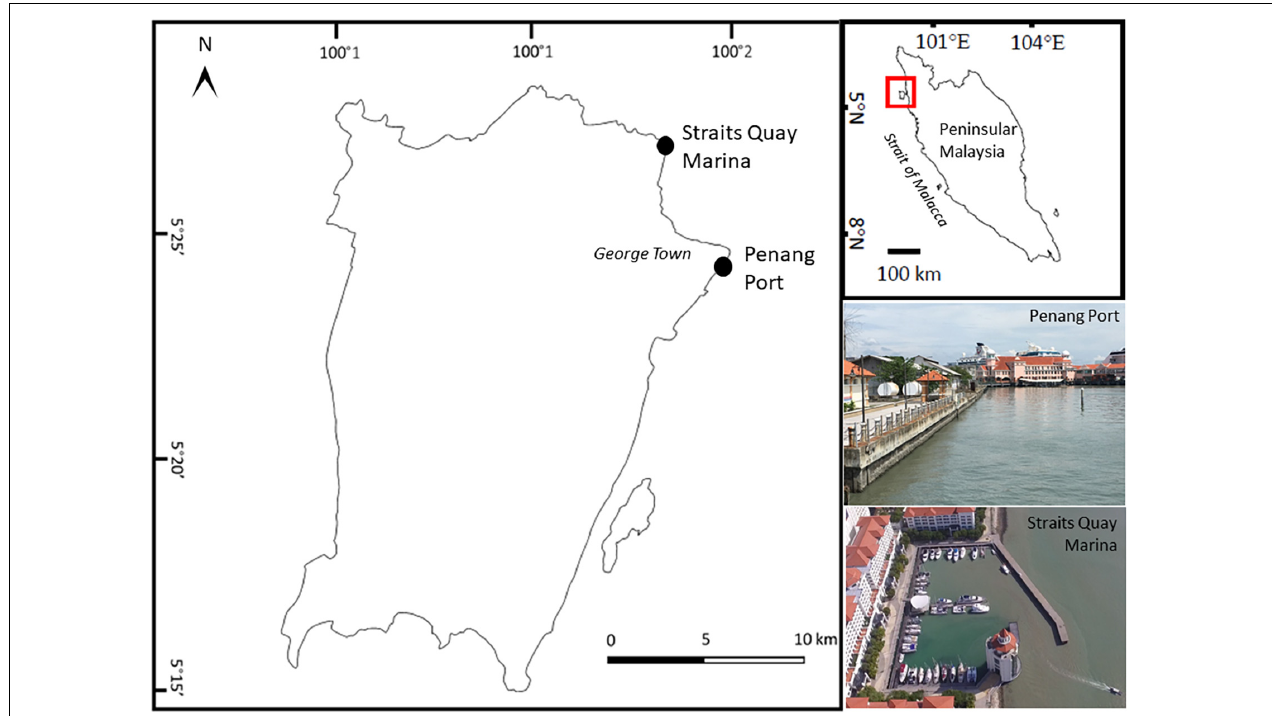
FIGURE 1 | Map of Penang Island, Malaysia, showing experimental sites, Straits Quay Marina and Penang Port.